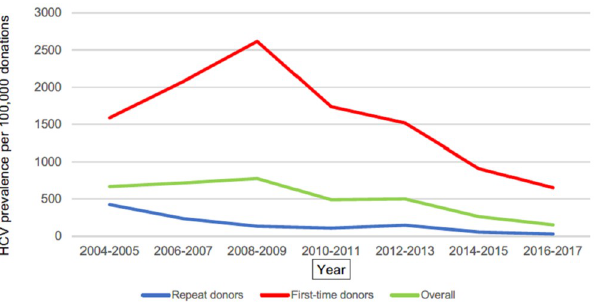
Fig 2. HCV prevalence per 100,00 donations. Annual trends of HCV prevalence per 100,000 donations in the National Blood Center of Lithuania from 2004 to